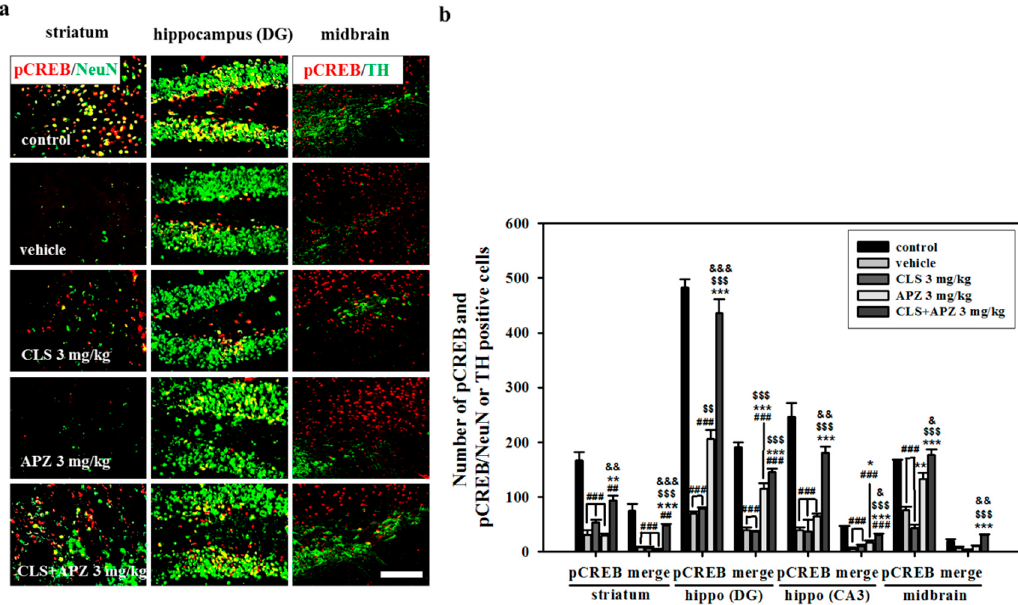
Figure 6. Effect of APZ augmentation on the phosphorylation of cyclic adenosine monophosphate response element binding protein (CREB) and its localization in CLS-treated mice. Photomicrograph ( a ) and its histogram ( b ) for pCREB in all regions examined, pCREB/NeuN in the striatum and hippocampus (DG and CA3) and pCREB/TH in the midbrain. pCREB-positive cells were significantly increased by the combined use of APZ and CLS in all regions examined ( n = 5). Additionally, pCREB/NeuN or TH-double positive cells were recovered in the striatum, hippocampus and midbrain by the combined use of APZ and CLS. DG, dentate gyrus; CA3, cornu ammonis; hippo, hippocampus. ## p < 0.01 and ### p < 0.001 versus control mice; * p < 0.05, ** p < 0.01 and *** p < 0.001 versus vehicle-treated mice; $$ p < 0.01 and $$$ p < 0.001 versus CLS-treated mice; & p < 0.05, && p < 0.01 and &&& p < 0.001 versus APZ-treated mice. Scale bars = 100 μ m.